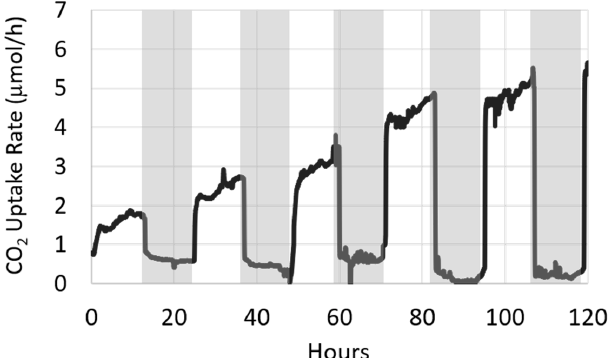
Figure 7. The photoautotrophic biofilm in BR cons was illuminated on a cycle of alternating 12 h light and dark periods. On–off toggling of biofilm photosynthesis and CO 2 uptake is readily apparent. Following each dark period, CO 2 uptake rebounded to approximately the same level reached at the end of the previous light period. Time zero refers to twenty hours post inoculation.